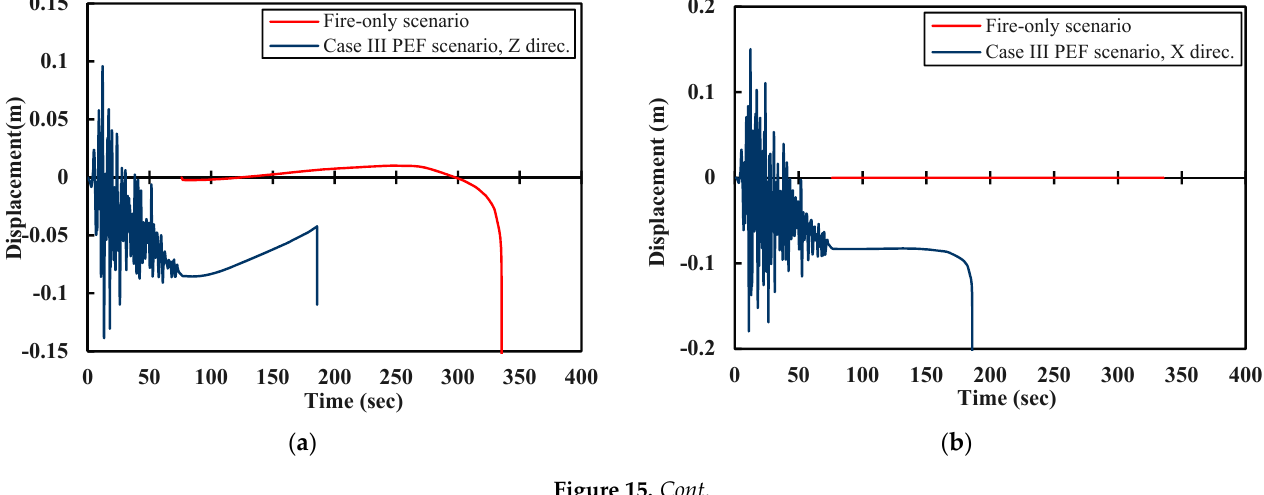
Figure 14. Images from a Case III PEF analysis with a real earthquake (PGA = 0.35 g, natural period = 0.24 sec), bi-directional excitation in the x- and z-direction including ( a ) the residual deformation of the structure at the end of earthquake event and ( b ) the shape and mechanism of failure of the structure after the PEF event. Fire-only scenario Case III PEF scenario, Z direc.